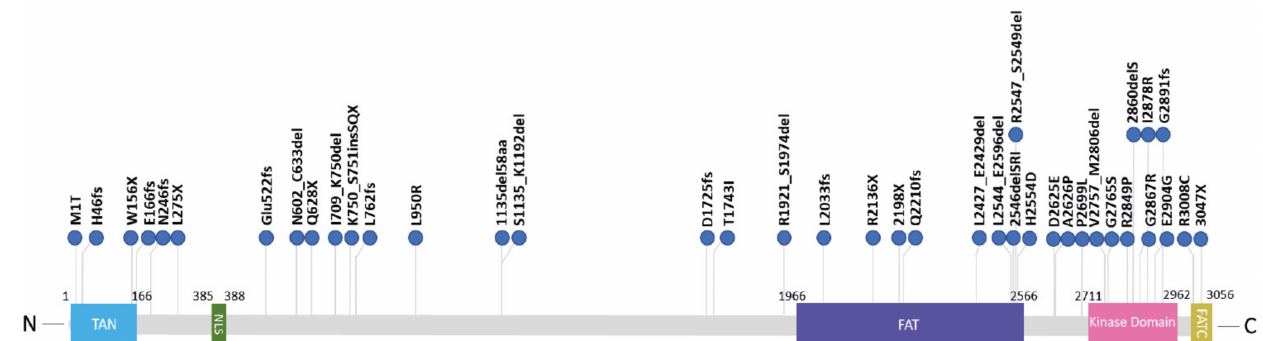
Figure 1. Distribution of ATM amino acid substitutions in ATM-KD patients. Schematic representation of the ATM protein 189 indicating the location of kinase dead mutations that are spread across the whole protein. The TAN (Tel1/ATM N-termi- 190 nal), NLS (Nuclear Localization Signal), FAT (FRAP-ATM-TRRAP), Kinase, and FATC (FRAP-TM-TRRAP-C-terminal) domains are indicated. Table 1. ATM mutations identified in A-T patients where ATM protein without kinase activity is expressed.